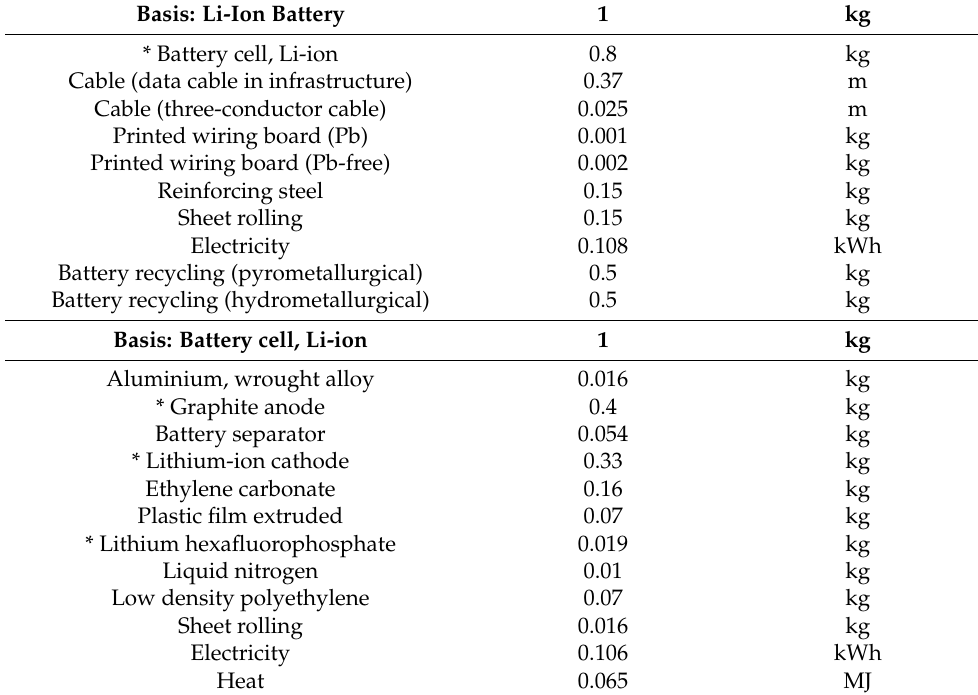
Figure 2. Activities and materials involved in the life cycle of BESS. Table 1. Life cycle inventory of Li-ion battery (Ecoinvent 3.0: Battery, Li-ion, rechargeable, prismatic {GLO}| production). * shows which system is further expanded for the life cycle inventory—these systems are chosen to show the life cycle impact hotspot later on.